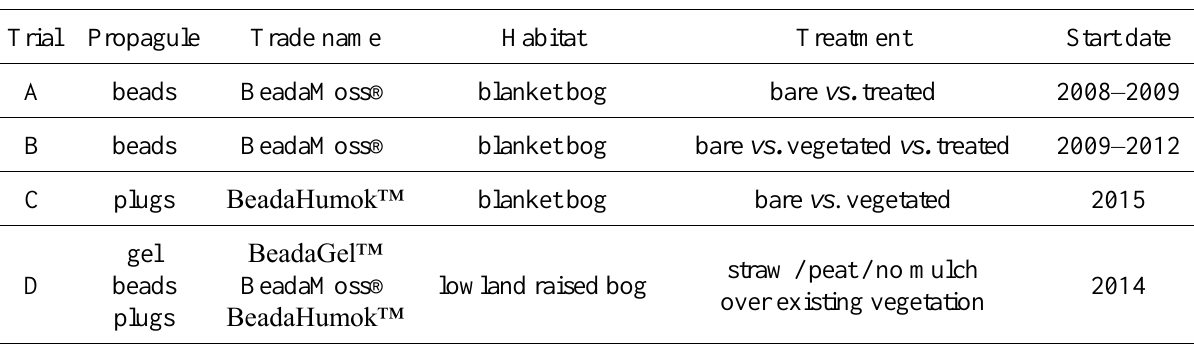
Table 2. Sphagnum propagation materials, locations and dates of the field trials. Trials A–C were conducted in the Peak District National Park, and Trial D on the Manchester Mosslands (See Methods for further details). The terms ‘bare’, ‘treated’ and ‘vegetated’ are explained in Table